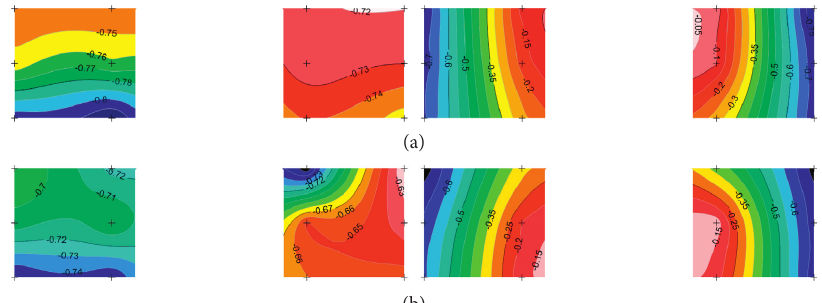
Figure 17: Mean wind pressure coefficients of wall CD in the y -direction. (a) Wall CD at the upper opening in the model of L-3 (expanding along the axis, the left side represents the C side (the flow flows from left to right); the right side represents the D side (the flow flows from right to left), the same below). (b) Wall CD at the lower opening in the model of L-3.